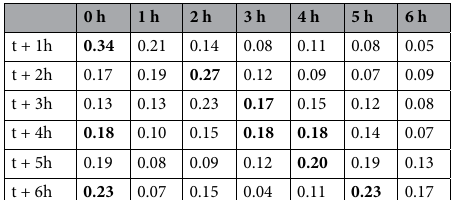
0 h 1 h 2 h 3 h 4 h 5 h